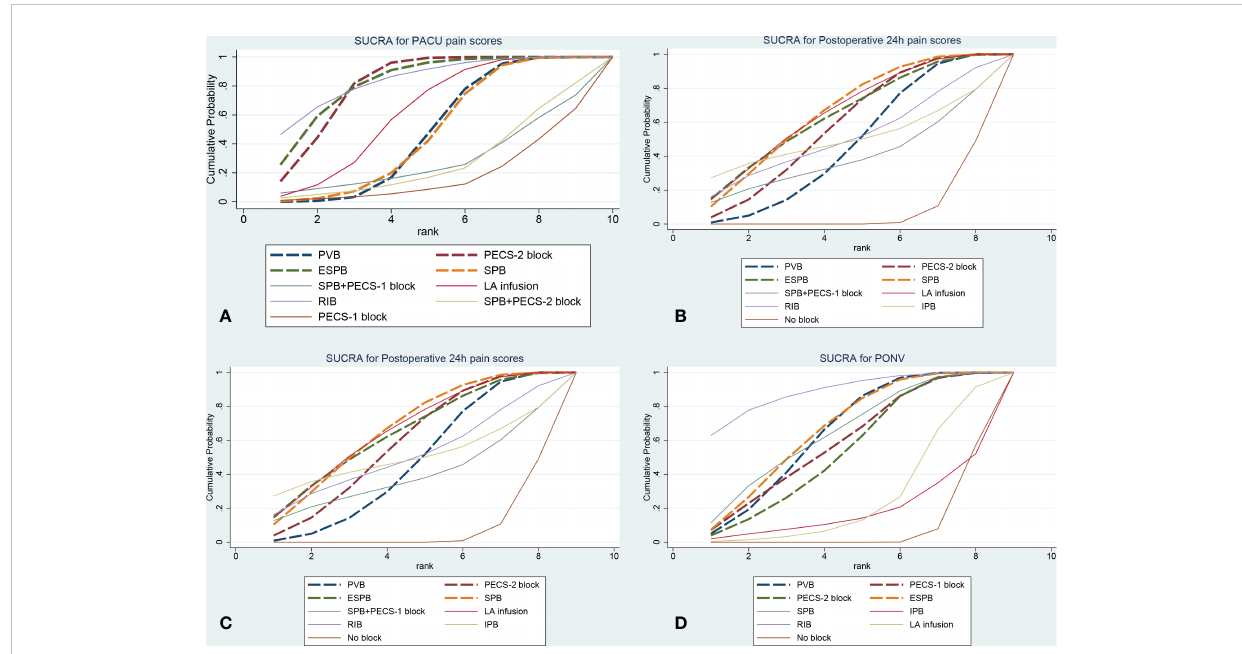
FIGURE 3 The plot of cumulative ranking curve (A) : PACU pain scores, (B) : Postoperative 24h pain scores, (C) : Postoperative 24h morphine consumption, (D) : Incidence of PONV). The area under the curve is proportional to SUCRA. ESPB, erector spinae plane block; PECS-2 block, pectoral nerves-2 block; PECS-1 block, pectoral nerve-1 block; PVB, paravertebral nerve block; SPB, serratus anterior plane block; IPB, interpleural block; LA infusion, local anesthetic